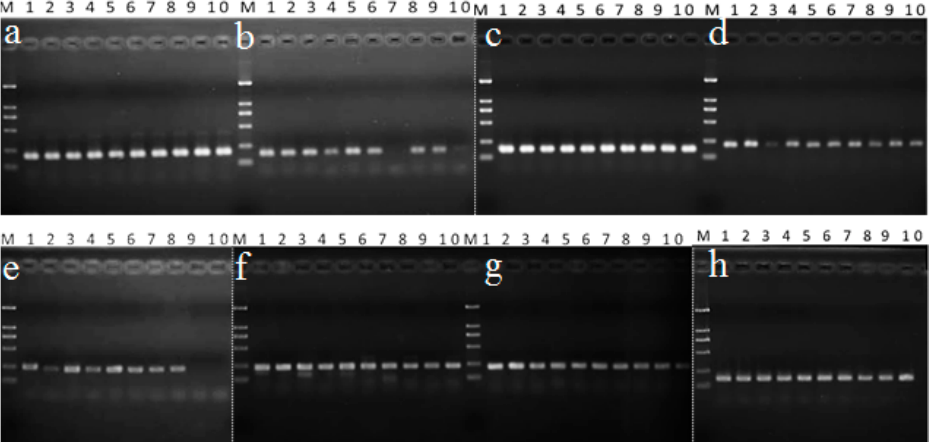
Figure 2. Validation of generality of the selected reference genes in different Morchella species. The order of the phylogenetic name of the species indicated as lanes 1–5 represent Mel-10, Mel-6, Mel-21, Mel-21/33 and Mel-13/26 belonging to Elata clade, while Lanes 6-10 represent Mes-23/24, Mes-6, Mes-21, Mes-19 and Mes-24 belonging to Esculenta clade. Selected reference genes: ( a ) ACT1; ( b ) ATU1; ( c ) AEF3; ( d ) CYC3; ( e ) INTF2; ( f ) INTF3; ( g ) INTF4; ( h ) INTF7; The gels of different batches were separated by the white dotted line.